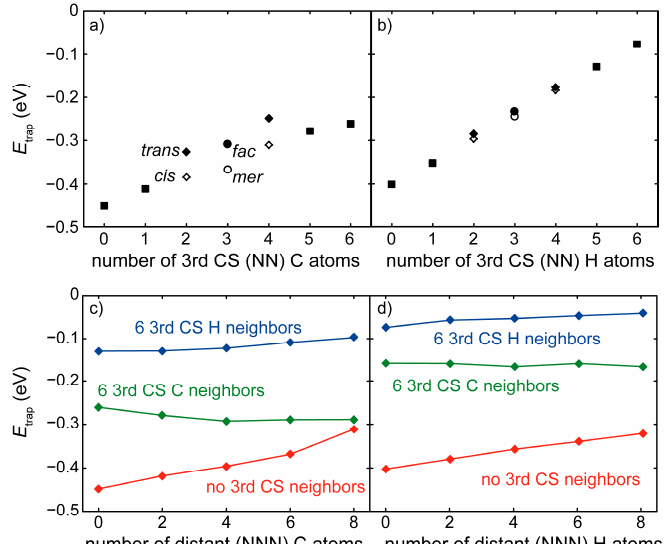
Figure 6. Trapping energies E trap for a single H atom in the central κ position as a function of the number of C or H atoms in various κ positions in a 3 × 3 × 3 L 1 2 -Fe 3 Al supercell. ( a ) C atoms are present as nearest neighbors for H in the third CS (nearest κ neighbors, NN), under consideration of structural isomers. The lattice parameter is a = 3.69 Å. Squares signify arrangements without structural isomers with zero, one, five, or six neighbors; open/closed diamonds signify the two isomers for two neighbors ( cis and trans ); open/closed circles signify the two arrangements for three neighbors ( mer and fac ). ( b ) As before but for H atoms in the third CS. Energetic differences between structural isomers are negligible in this case. The lattice parameter is a = 3.65 Å. ( c ) C atoms are next-nearest neighbors (NNN) located at the cell corners ( d C–C = 6.4 Å), with no atoms (red diamonds), six H atoms (blue diamonds) or six C atoms (green diamonds) located simultaneously in the third CS (NN) κ positions, respectively. Lattice parameter as in ( a ). ( d ) As in ( c ), but considering H atoms as NNN neighbors. Lattice parameter as in ( b ). The difference in a explains the slight energetic difference in the case of zero NN/NNN neighbors.